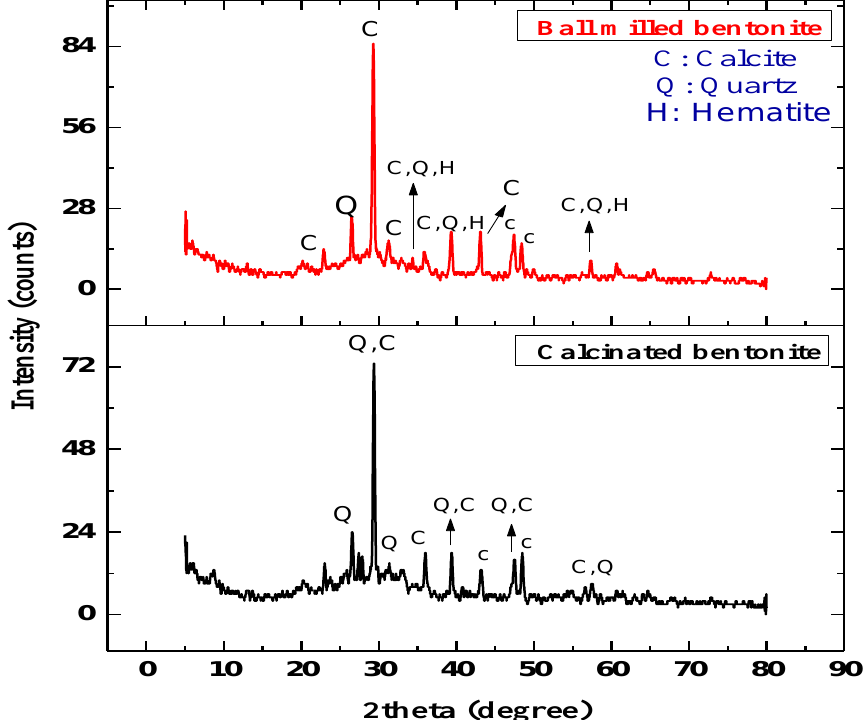
Figure 1. XRD patterns for the calcinated and ball-milled bentonite clay. Clay minerals denoted are calcite (C), quartz (Q), and hematite (H).